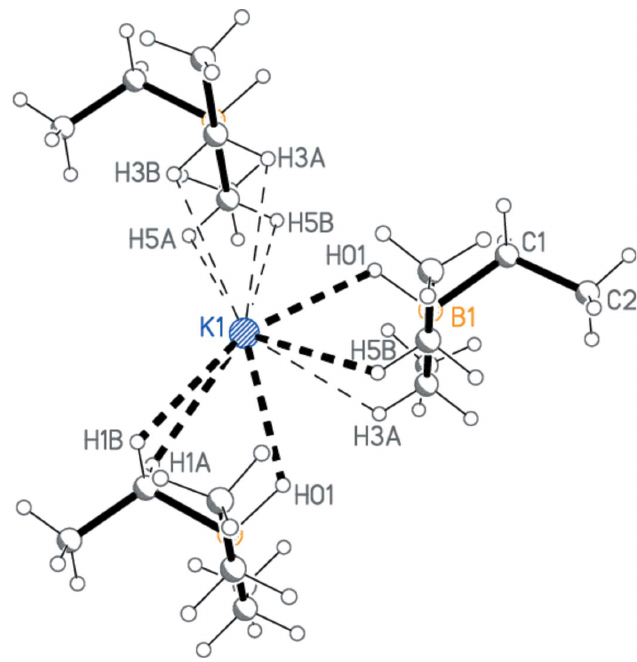
Figure 2 The environment of the potassium atom in KHBEt 3 , showing ten of the eleven K—H contacts < 3 A˚ to three neighbouring hydridotriethylborate units. Radii are arbitrary. K—H distances shorter than 2.8 A˚ are shown as thick dashed bonds, whereas those greater than 2.9 A˚ are shown as thin dashed bonds. The anion on the right corresponds to the asymmetric unit; the anions at top and bottom were generated by the operators 1 (cid:3) y , 1 (cid:3) z , respectively. The contact to H2 B of a fourth 1 (cid:3) z and (cid:3) 1 + x , 3 2 2 anion (at 1